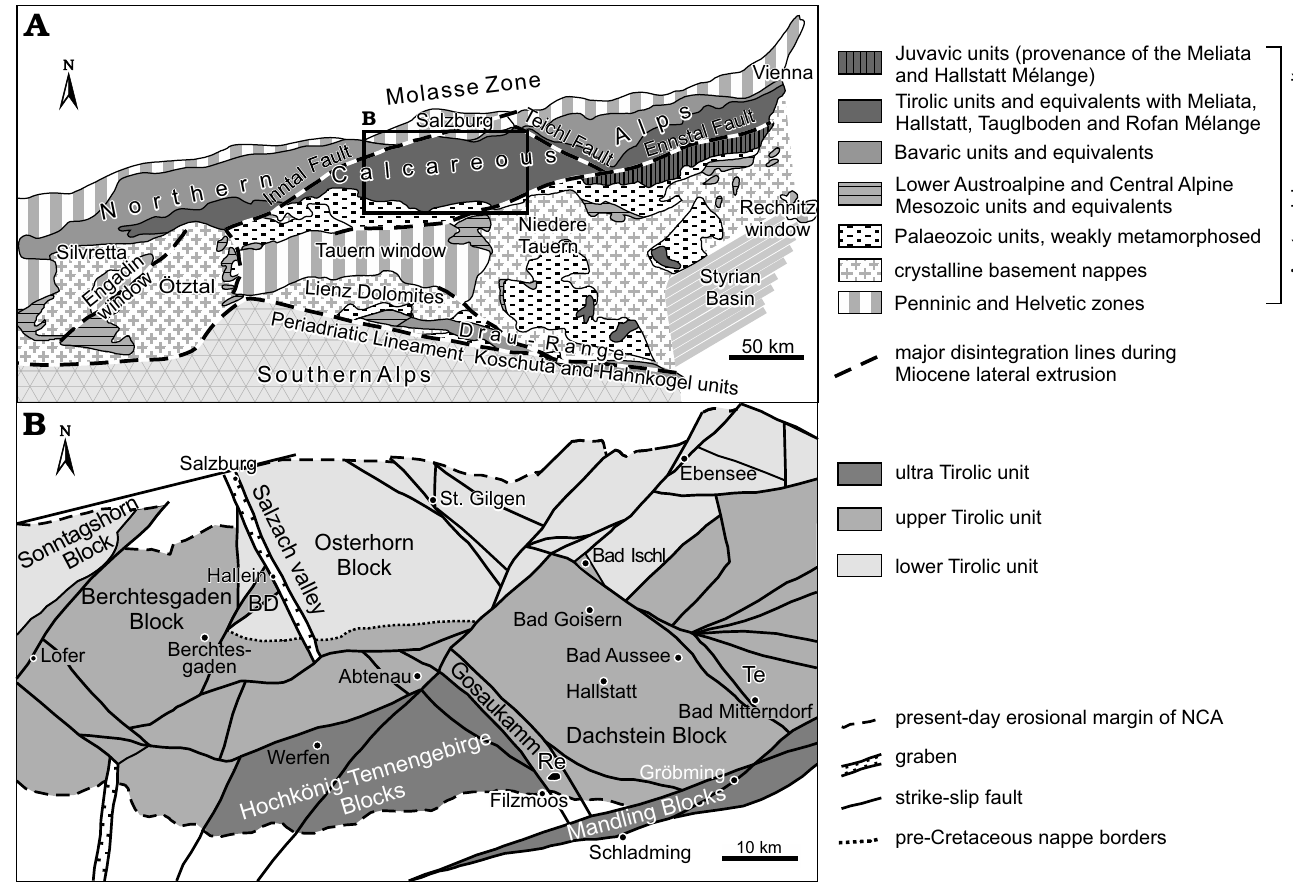
Fig. 1. A . Structural overview maps of the Alpine orogen, showing the situation of the central Northern Calcareous Alps. B . The middle sector of the central Northern Calcareous Alps with locations mentioned in the text indicated (modified from Frisch and Gawlick 2003). Abbreviations: Re, Mount Rettenstein; BD, Bad Dürrnberg; Te,